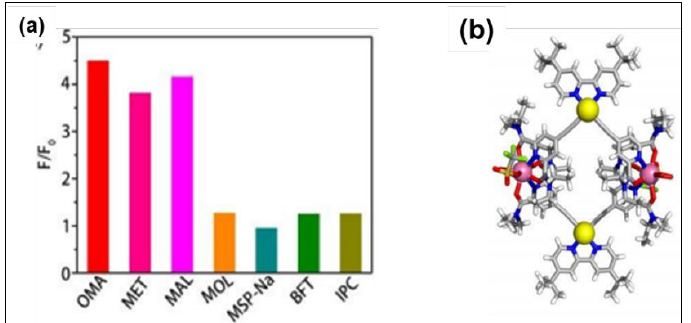
Figure 17. ( a ) Luminescence response to various pesticides, and ( b ) X-ray crystal structure of O29 (C, gray; H, white; N, blue; O, red; S, orange; F, light green; Pt, yellow; Eu, pink). Reproduced with permission from ref. [80].